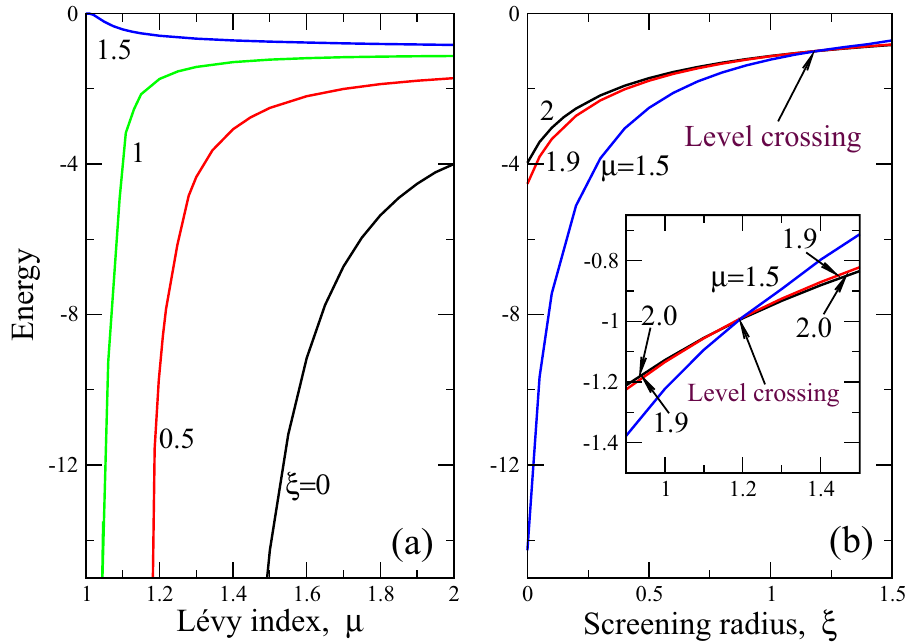
Figure 3. Ground state energy (in the units E 0 µ (12)) as a function of Lévy index µ ( a ) and dimensionless screening radius ξ (b). Figures near curves define the screening radius (panel ( a )) and Lévy index (panel ( b )). Inset to panel ( b ) details the behavior of ground state energy at ξ > 0.9 , where energy levels crossing occurs approximately at ξ ≈ 1.15 . Levels crossing point is the same for all 1 < µ < 2 and occurs for finite screening